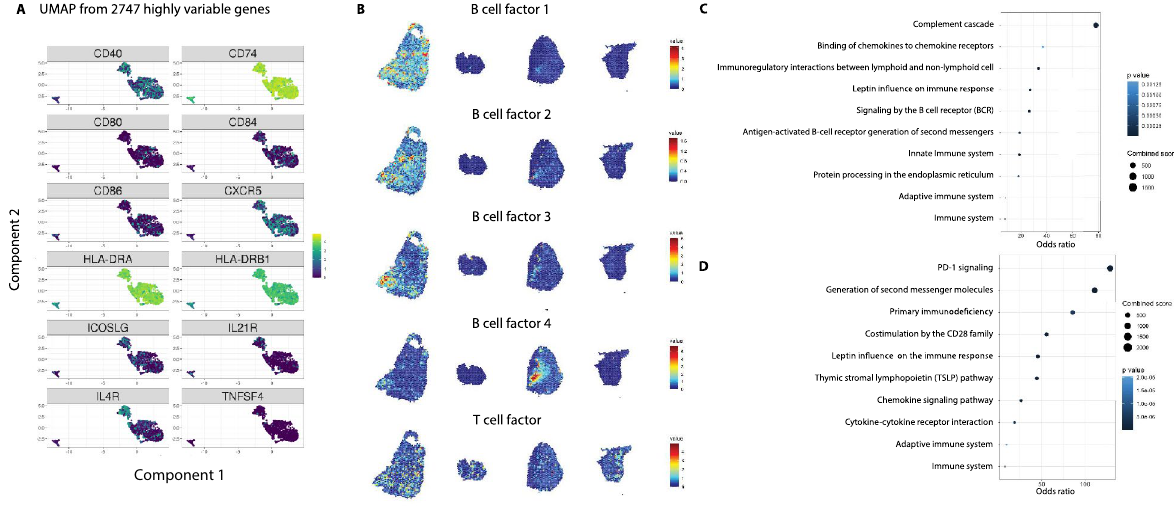
Figure 3. T cell interaction as a means of B cell maturation in the synovial tissue. ( A ) Expression of genes associated with antigen presentation and costimulation are displayed on the three major clusters formed from the single B cell RNAseq. ( B ) Upon factor analyses, four B cell factors and one T-B cell interaction factor are shown with factor activities. These signatures overlap in distinct morphological areas of both ACPA− and ACPA+ tissue sections. ( C ) Pathway analysis from the top-20 genes for B cell and ( D ) T-B cell interaction factors (T cell factor) in B showed BCR signaling and PD-1 signaling,